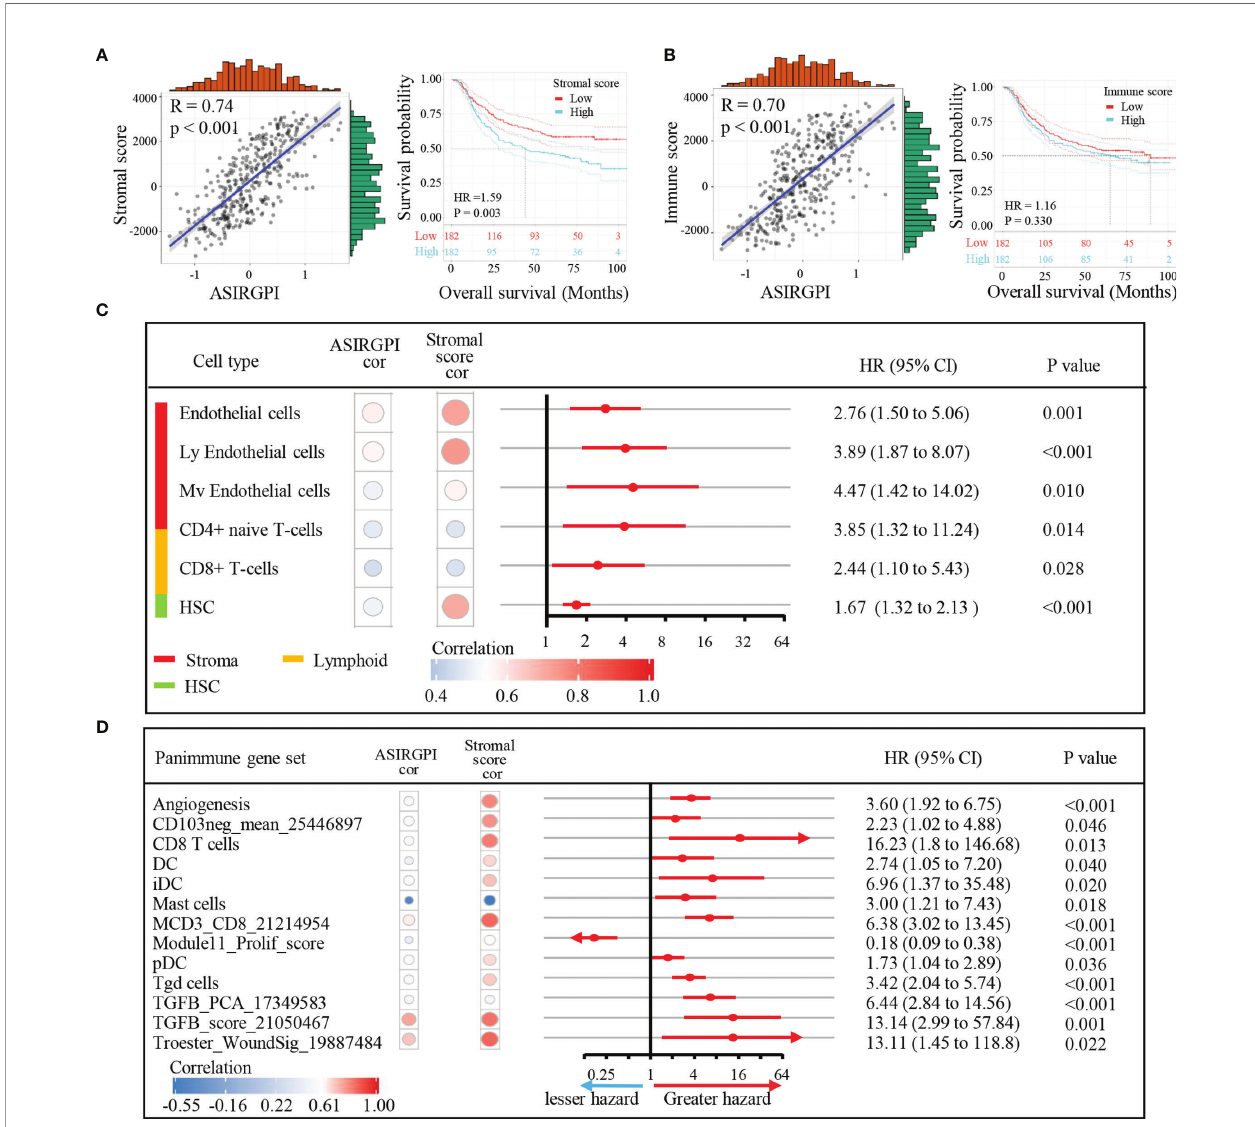
FIGURE 6 | Association of TME subcomponents and TME cell types with ASIRGPI and outcome in AGC patients. (A, B) Association of TME subcomponents with risk score and outcome in the entire 364 AGC cohort. (A) Scatter plots depicting the positive correlation between stromal score and ASIRGPI in AGC patients. Pearson ’ s correlation coef fi cient is shown in the graphs (p < 0.001). Kaplan – Meier curves for overall survival of 364 AGC patients according to stromal score. Log- rank test, p = 0.003. (B) Scatter plots depicting the positive correlation between immune score and ASIRGPI. Pearson ’ s correlation coef fi cient is shown in the graphs (p < 0.001). Kaplan – Meier curves for overall survival of 364 AGC patients according to immune score. Log-rank test, p = 0.330. (C) TME cell type analysis, xCell, a method that uses gene expression signatures to infer the proportions of 64 immune and stromal cell types in samples, was utilized to determine the enrichment score of each cell type via ssGSEA. Among the 64 TME cell types, those signi fi cantly related to overall survival (log-rank test, p < 0.05) and risk score (Pearson ’ s correlation test, |r| ≥ 0.40, p < 0.05) are listed. The circular data markers indicate estimated hazard ratios. The error bars represent 95% CIs. Pearson ’ s correlation coef fi cients between nine TME cell types and stromal scores are also shown (p < 0.05). (D) Panimmune gene set analysis, gene set variation analysis (GSVA) was used to estimate the enrichment scores of 110 immunoregulation-related pathways in AGC samples. Among the 110 panimmune gene sets, those signi fi cantly related to overall survival (log-rank test, p < 0.05) and risk score (Pearson ’ s correlation test, |r| ≥ 0.40, p < 0.05) are listed. The circular data markers indicate estimated hazard ratios. The error bars represent 95% CIs. Pearson ’ s correlation coef fi cients between 13 panimmune gene sets and stromal scores are also shown (p <